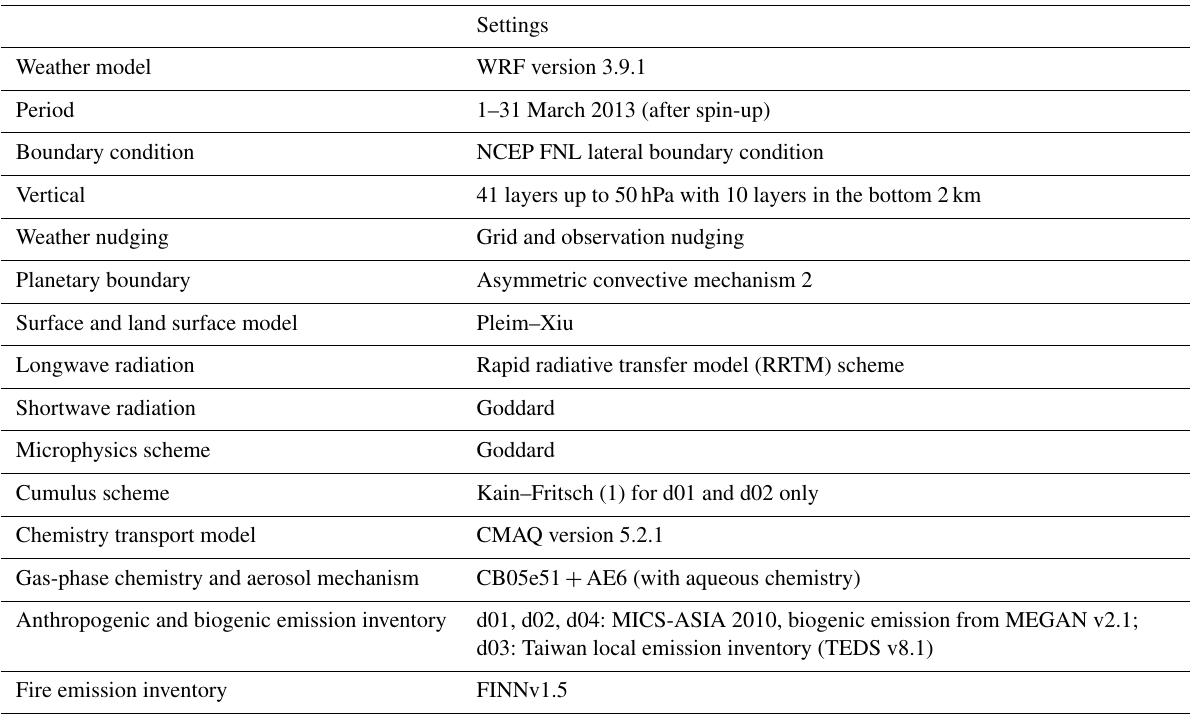
Table 1. WRF and CMAQ model settings.